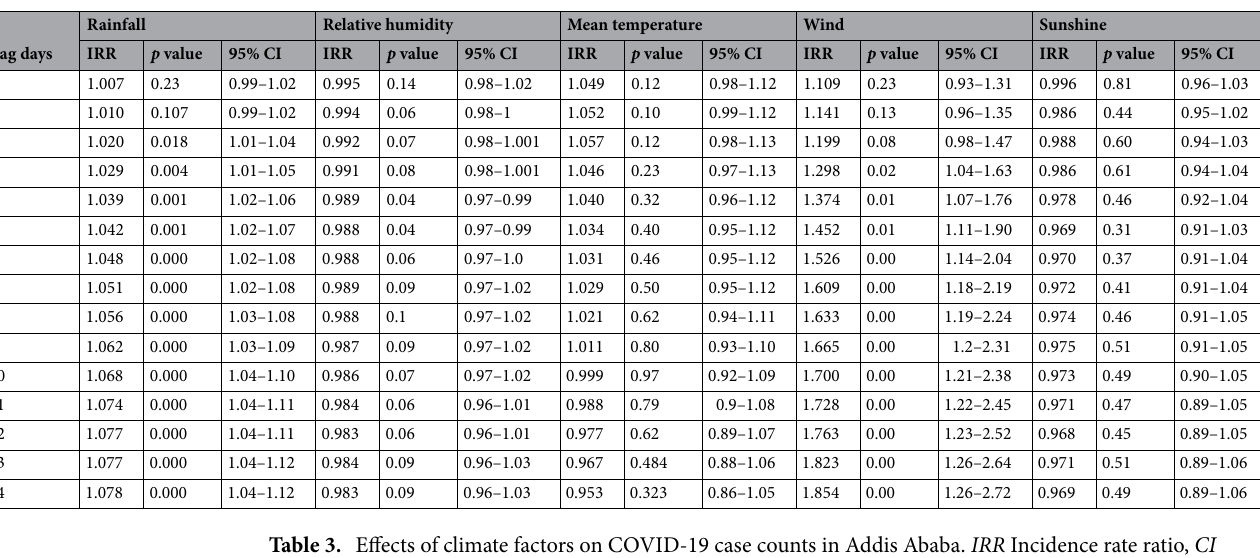
Table 3. Effects of climate factors on COVID-19 case counts in Addis Ababa. IRR Incidence rate ratio, CI confidence interval.